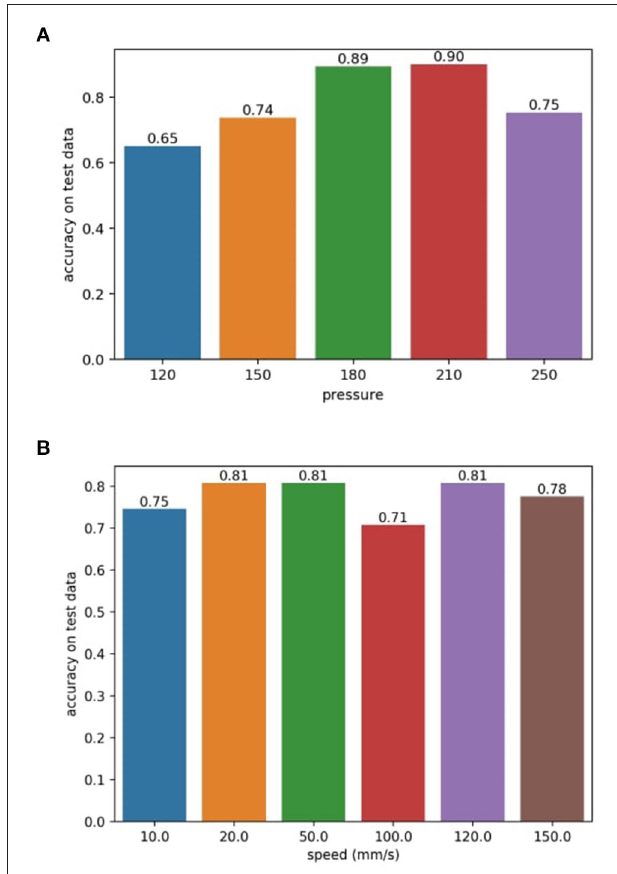
FIGURE 9 | (A) Sliding pressure (as the average value of the 16 taxel signals, unitless) vs. Classification accuracy (B) Sliding speed vs. Classification